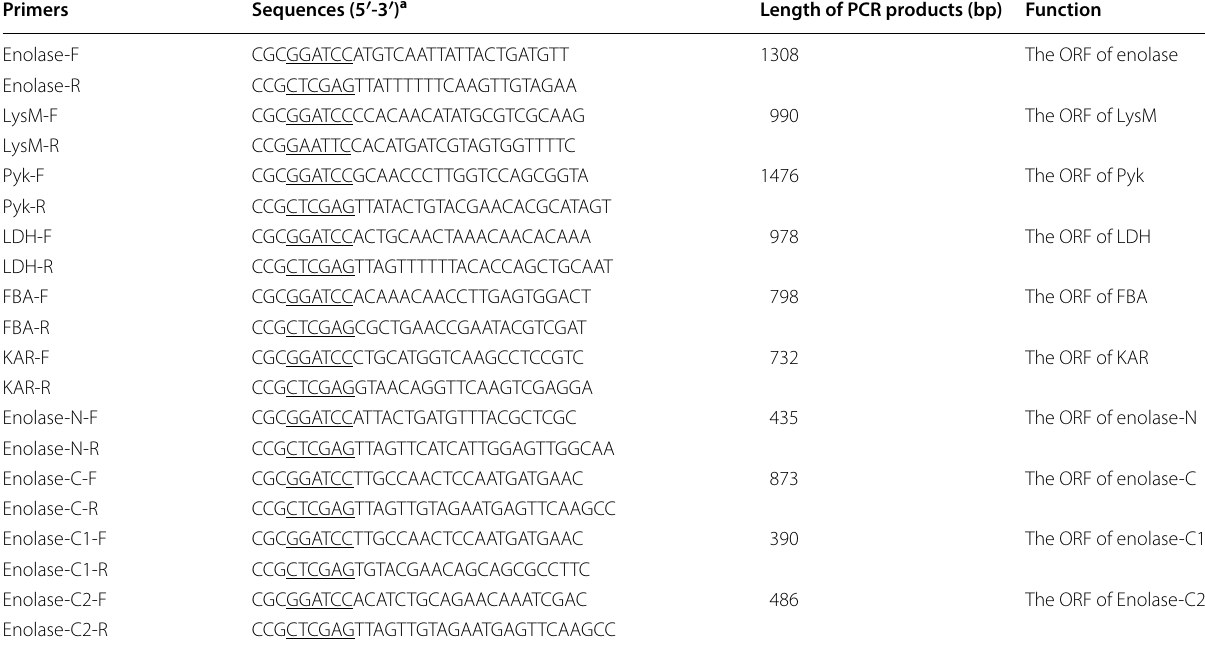
a The underlined sequences are restriction enzyme sites